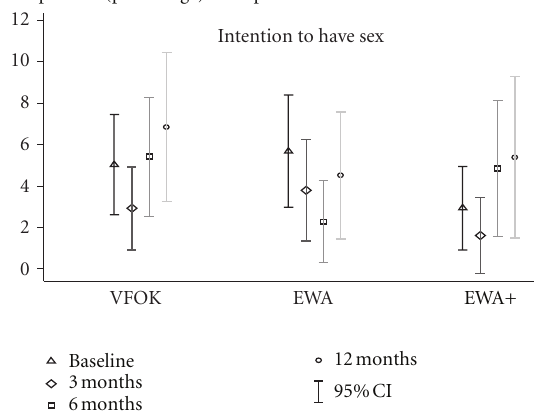
Figure 3: Percent of respondents with intention to have sex in the next 3 months by intervention (VFOK, EWA, and EWA+) and data collection point (3, 6, and 12